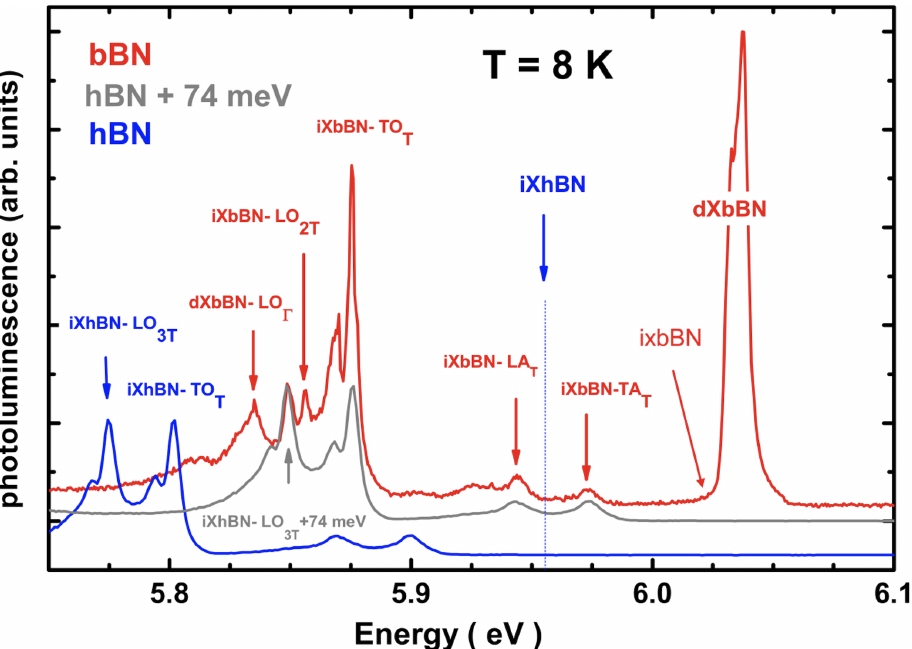
Figure 10. High resolution PL of a high-quality hBN crystal (blue) and of a piece of sp 2 -bonded BN with highly dominating bBN (red). The hBN PL is re-plotted in gray after being blue-shifted 74 meV. The energies of the indirect iXbBN and direct exciton dXbBN in bBN are indicated as well as the indirect exciton iXhBN in hBN. The different phonon replicas are also